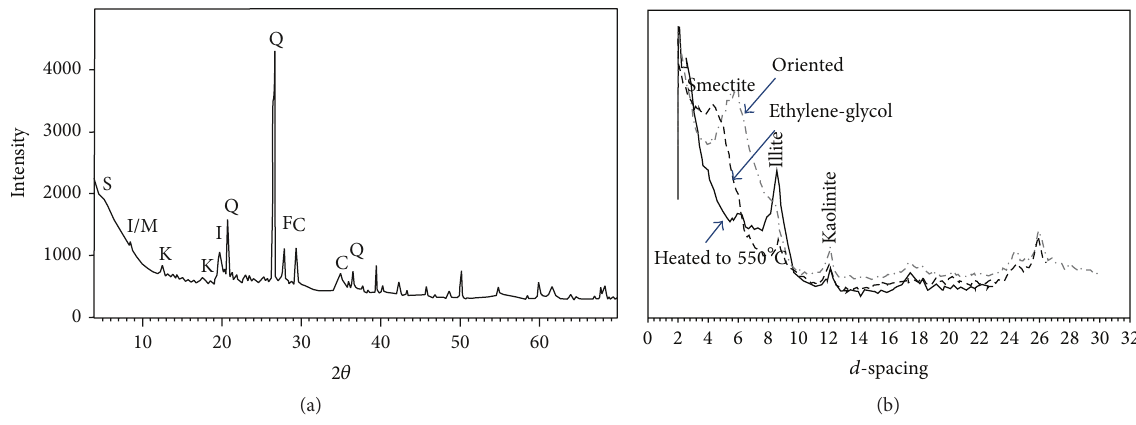
Figure 3: Typical XRD patterns of AC: (a) bulk (whole) sample and (b) clay fraction.